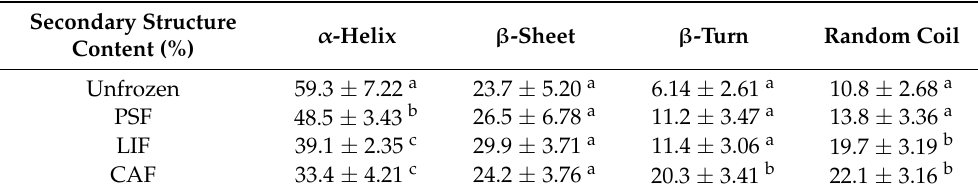
Table 2. Secondary amide I protein structure contents in different largemouth bass samples (unfrozen and in frozen storage under different freezing methods for 28